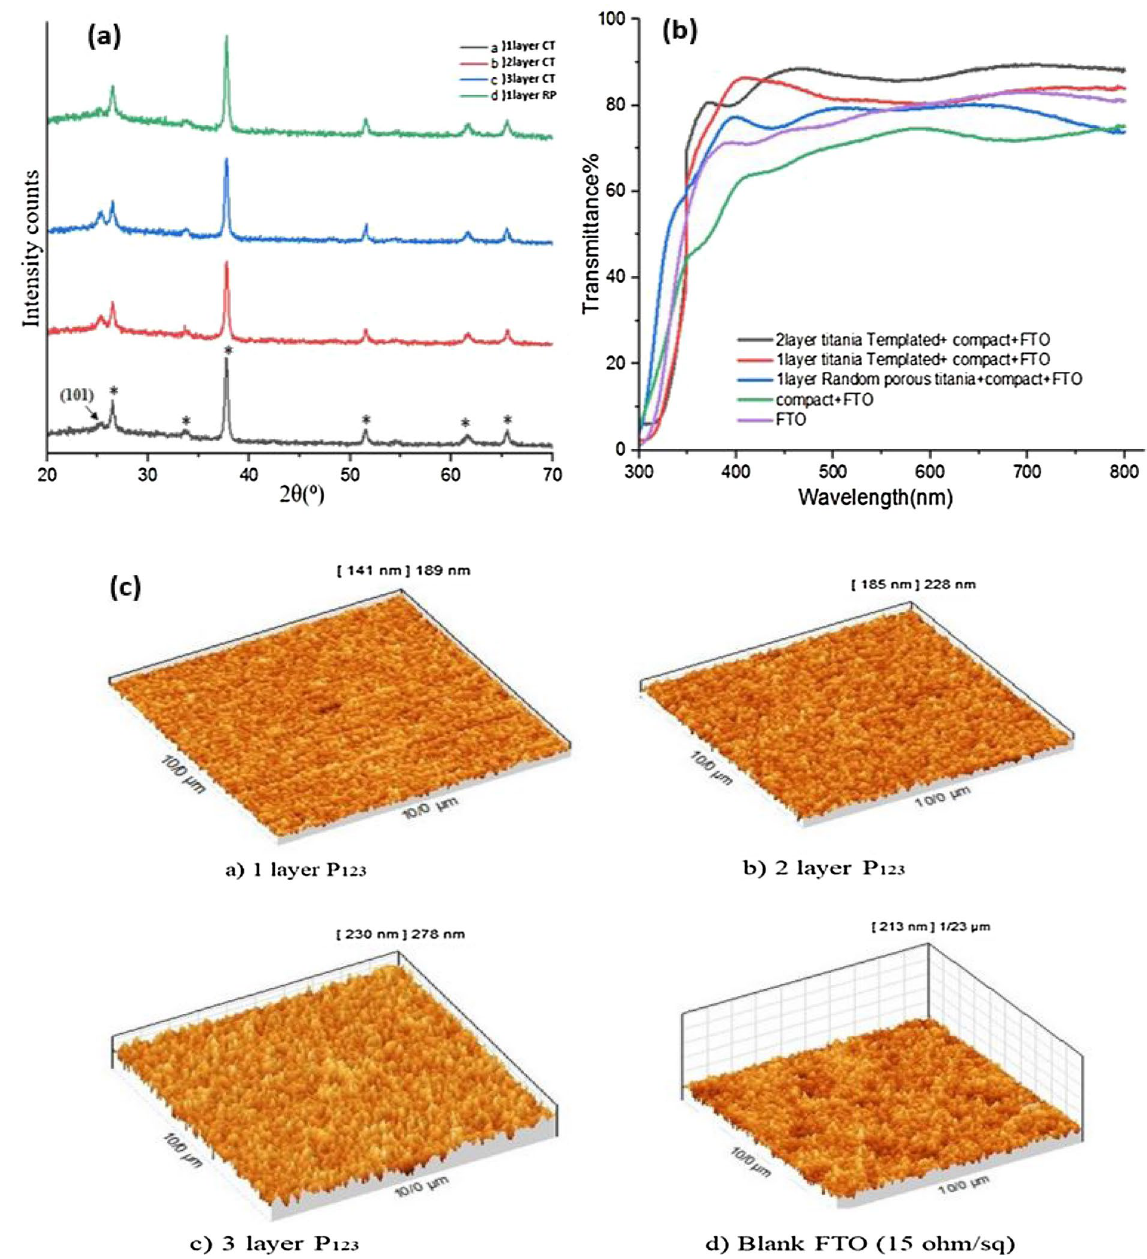
Figure 1. ( a ) XRD patterns of TiO 2 layers, black) FTO/1 layer CT-TiO 2 , red) FTO/2 layer CT-TiO 2 , blue) FTO/3 layer CT-TiO 2 , and green) FTO/1 layer RP-TiO 2. The symbol (*) corresponds to the peaks of the FTO substrate. ( b ) Transmittance spectra of TiO 2 layers coated on FTO with different configurations. ( c ) AFM of CT-TiO 2 layers placed on the FTO (15 Ω/sq).